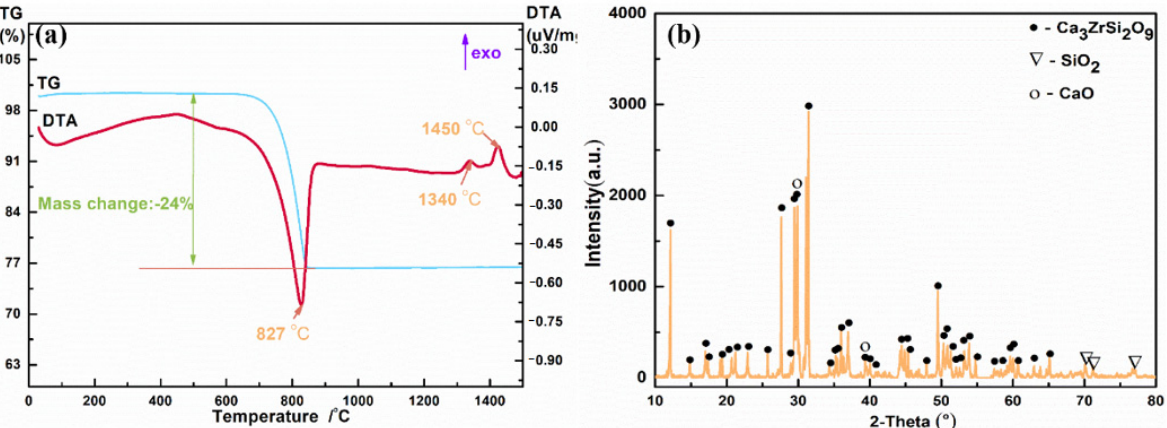
Figure 1. TG-DTA curve ( a ) of mixed powders before sintering (CaCO 3 :SiO 2 :ZrO 2 = 3:2:1 molar ratio) and XRD pattern ( b ) of Ca 3 ZrSi 2 O 9 powder after sintering.